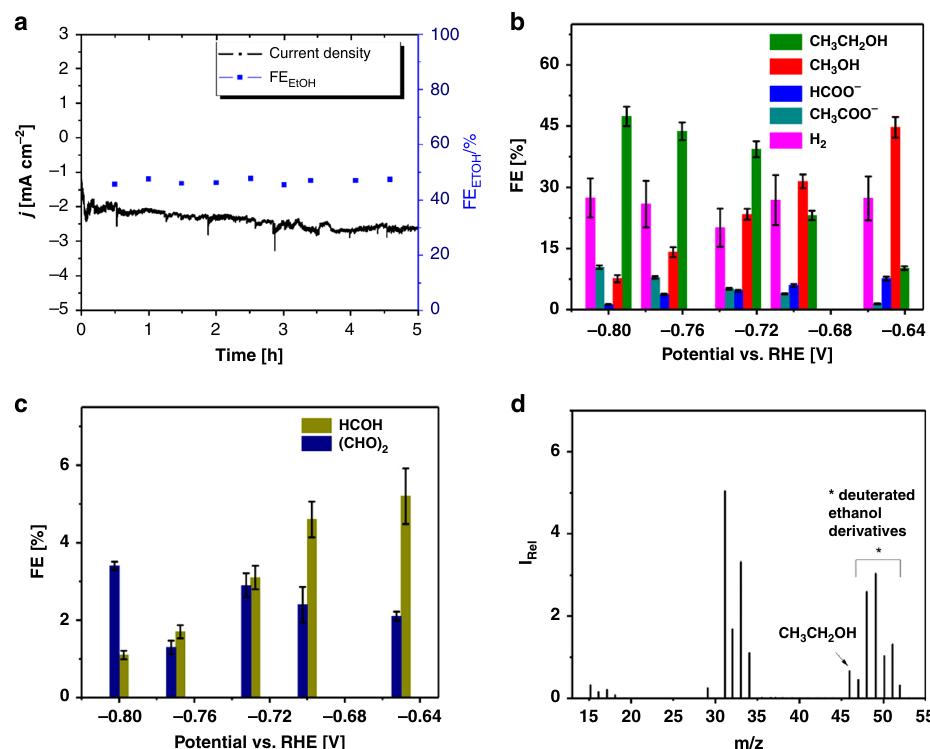
Fig. 2 a Constant potential electrolysis of electrochemical CO 2 reduction by the Co-corrole modi fi ed carbon paper electrode at a potential of − 0.8 V vs. RHE (black curve), Faradaic ef fi ciency for ethanol production over 5 h electrolysis (blue rectangles). b FE% vs. potential plot for potential dependent product formation. c FE% vs. potential plot for minor formed formaldehyde and solvated dimer of formaldehyde at different potentials. The error bars represent standard deviation of six measurements (three electrochemical reactions with two product analysis measurements for each reaction). d MS spectra obtained after electrolysis at − 0.8 V vs. RHE in (1:3) D 2 O/H 2 O 0.1 M NaClO 4 saturated with CO